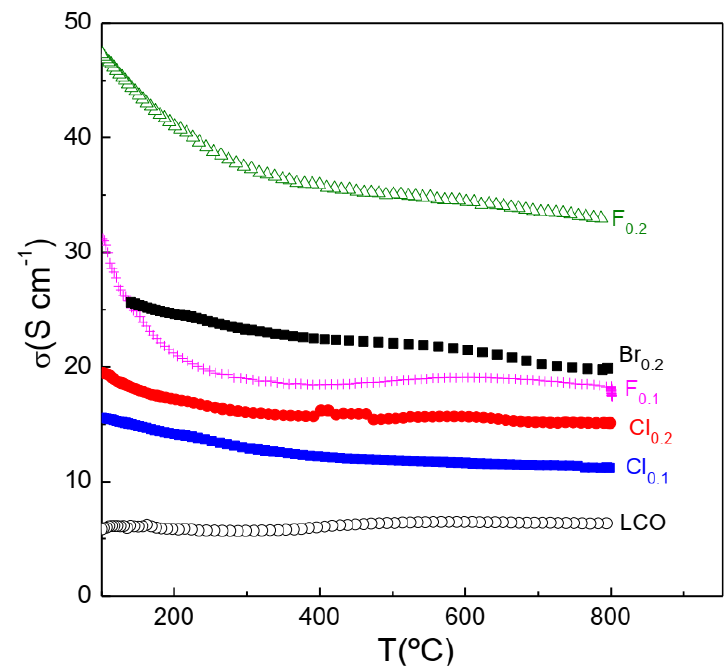
Figure 6. Variation of the conductivity with the temperature for La 2 CuO 4 − 0.5x A x (A = F, Cl, Br; x = 0.1, 0.2) series and undoped electrode (LCO).